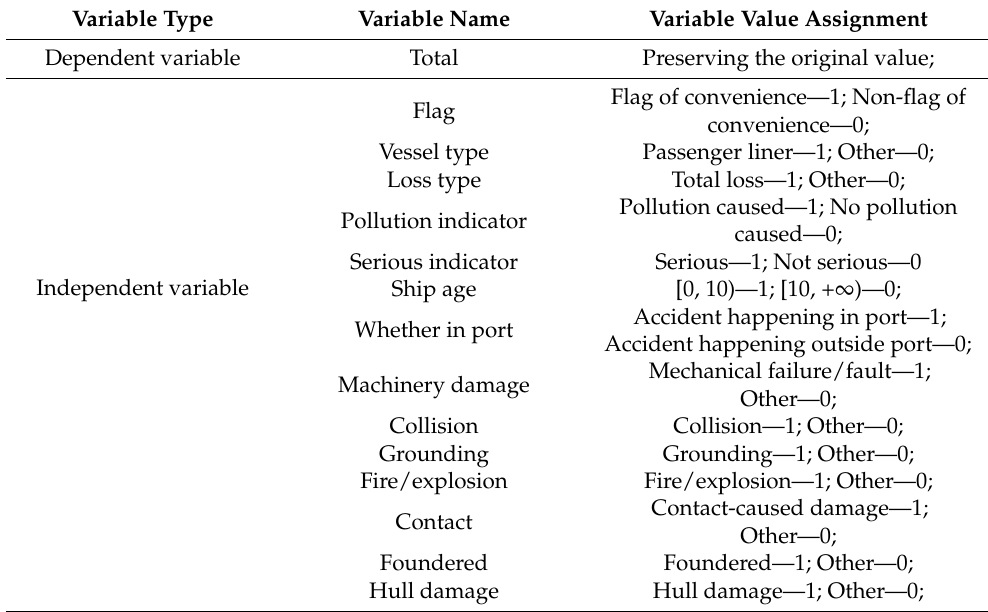
Table 2. Model variable